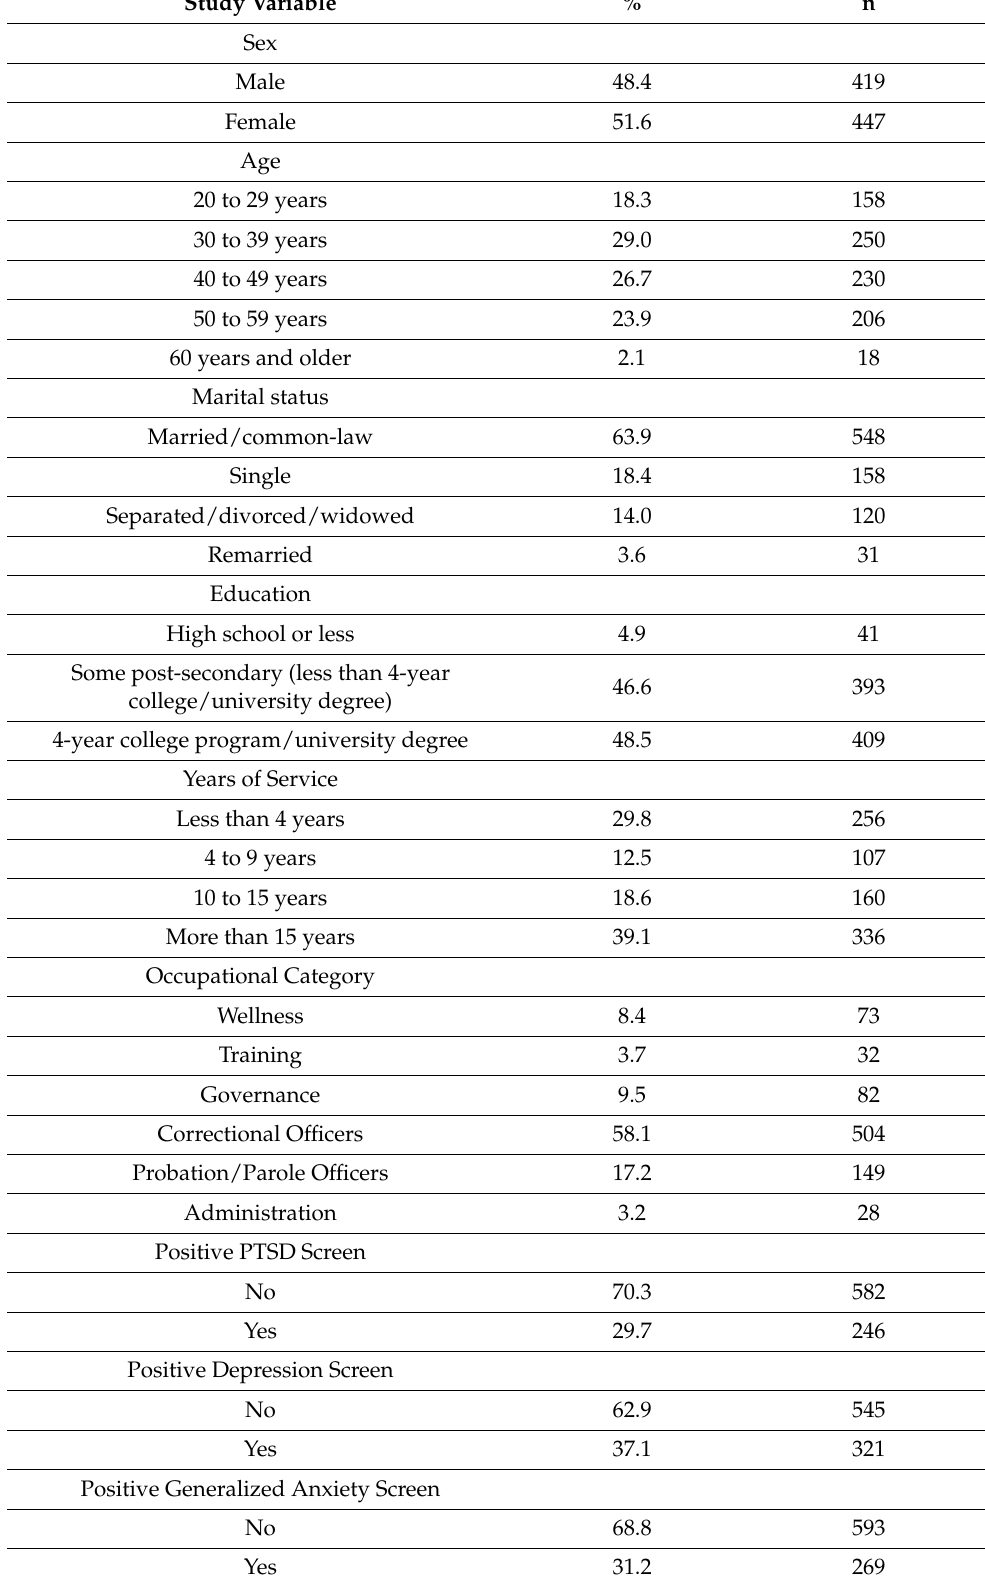
Table 1. Distribution of study variables in